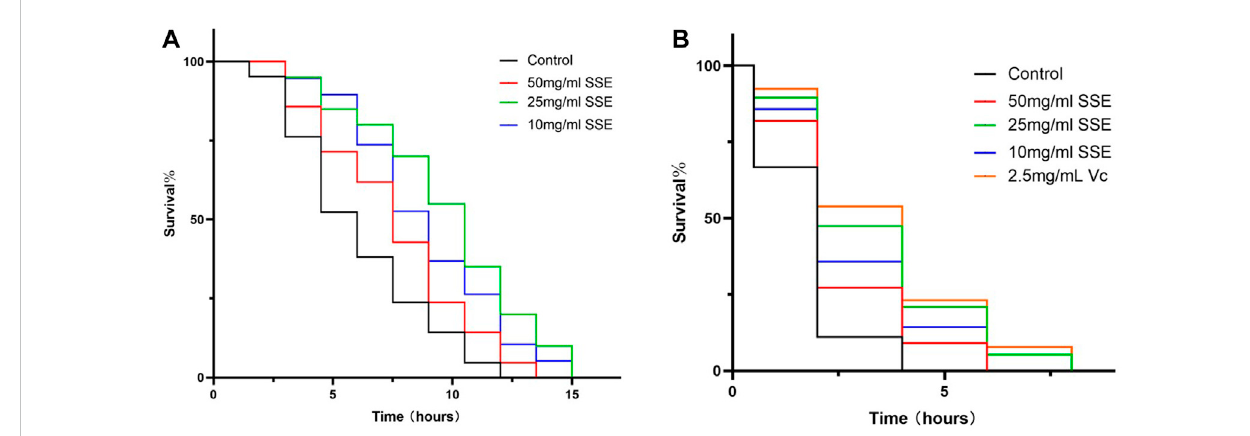
FIGURE 6 Effects of SSE on nematode stress resistance. (A) Survival times of nematodes when subjected to 37 ° C heat shock. (B) Survival times of nematodes under 3% H 2 O 2 , 2.5 mg/mL Vitamin C was used as a positive control.